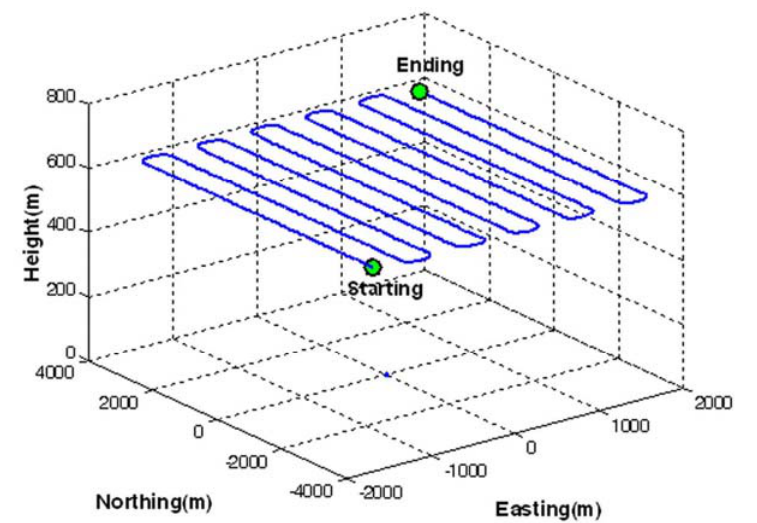
Figure 4. Generated reference